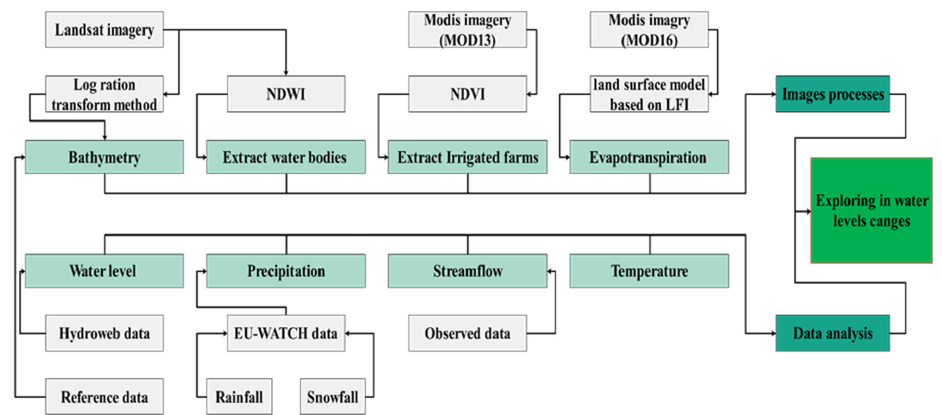
Figure 2. Data processing